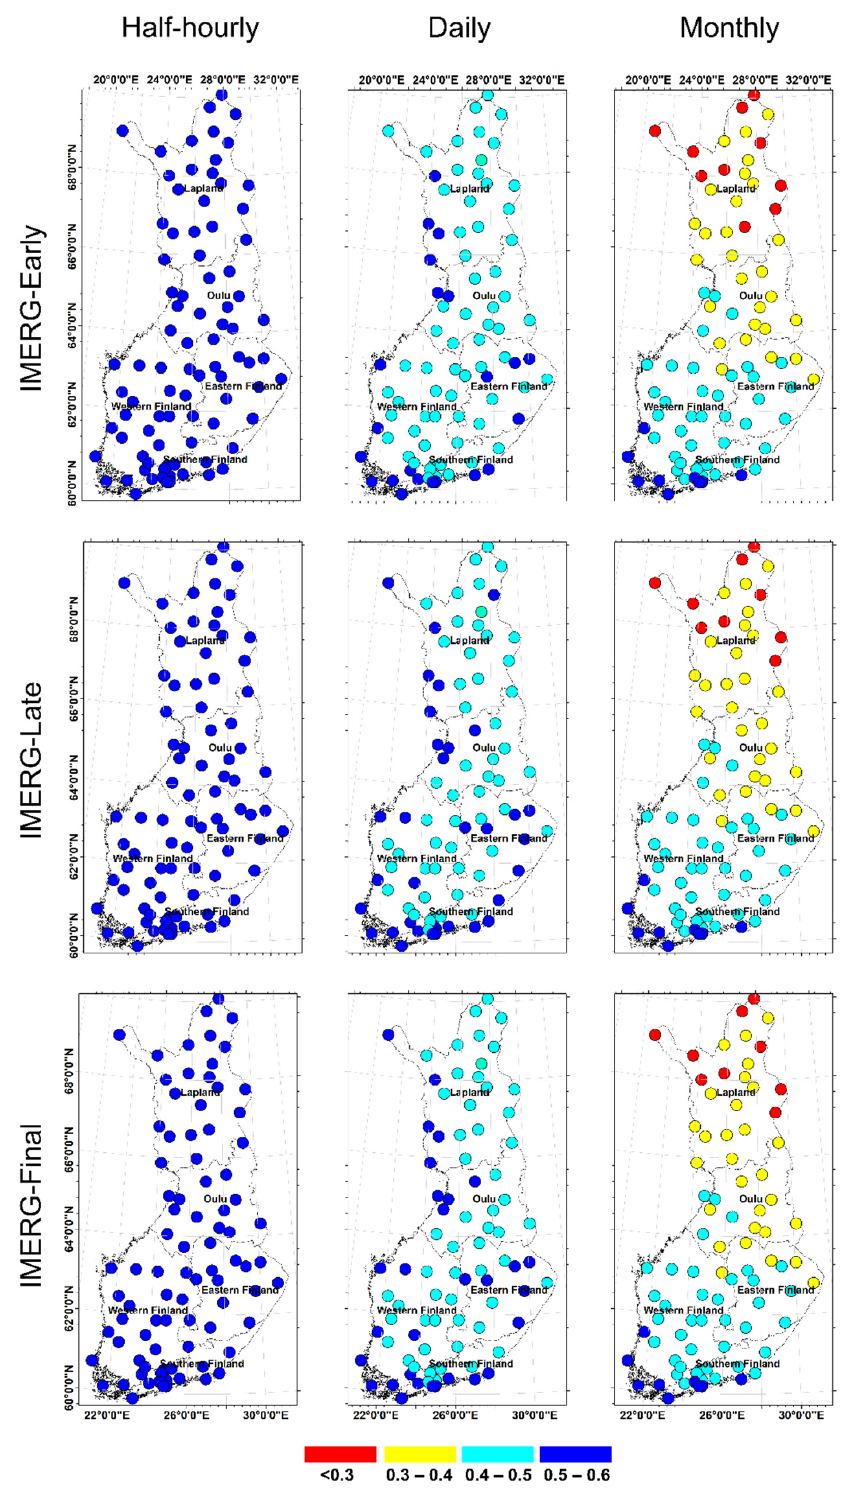
Figure 10. Spatial distributions of the hourly, daily, and monthly POD for IMERG-Early, IMERG-Late, and IMERG-Final.